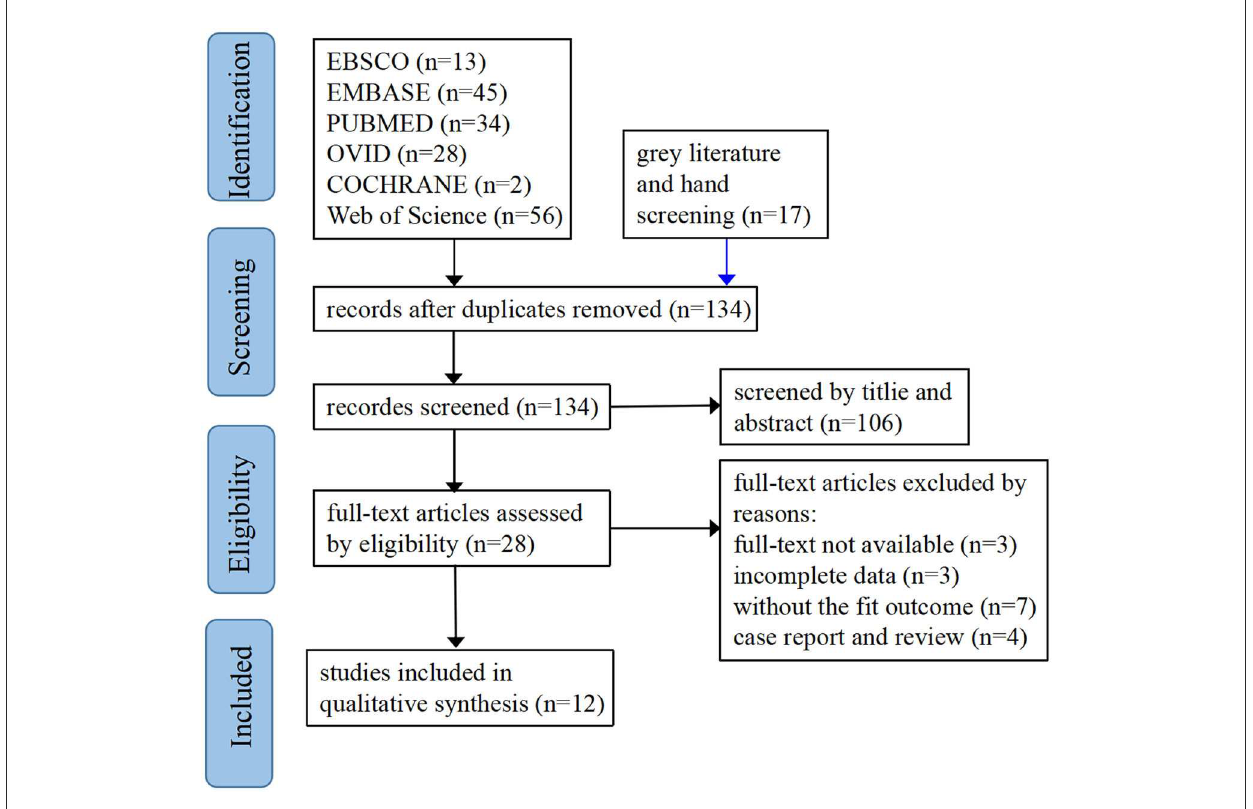
FIGURE1 PRISMA flow diagram of screening studies